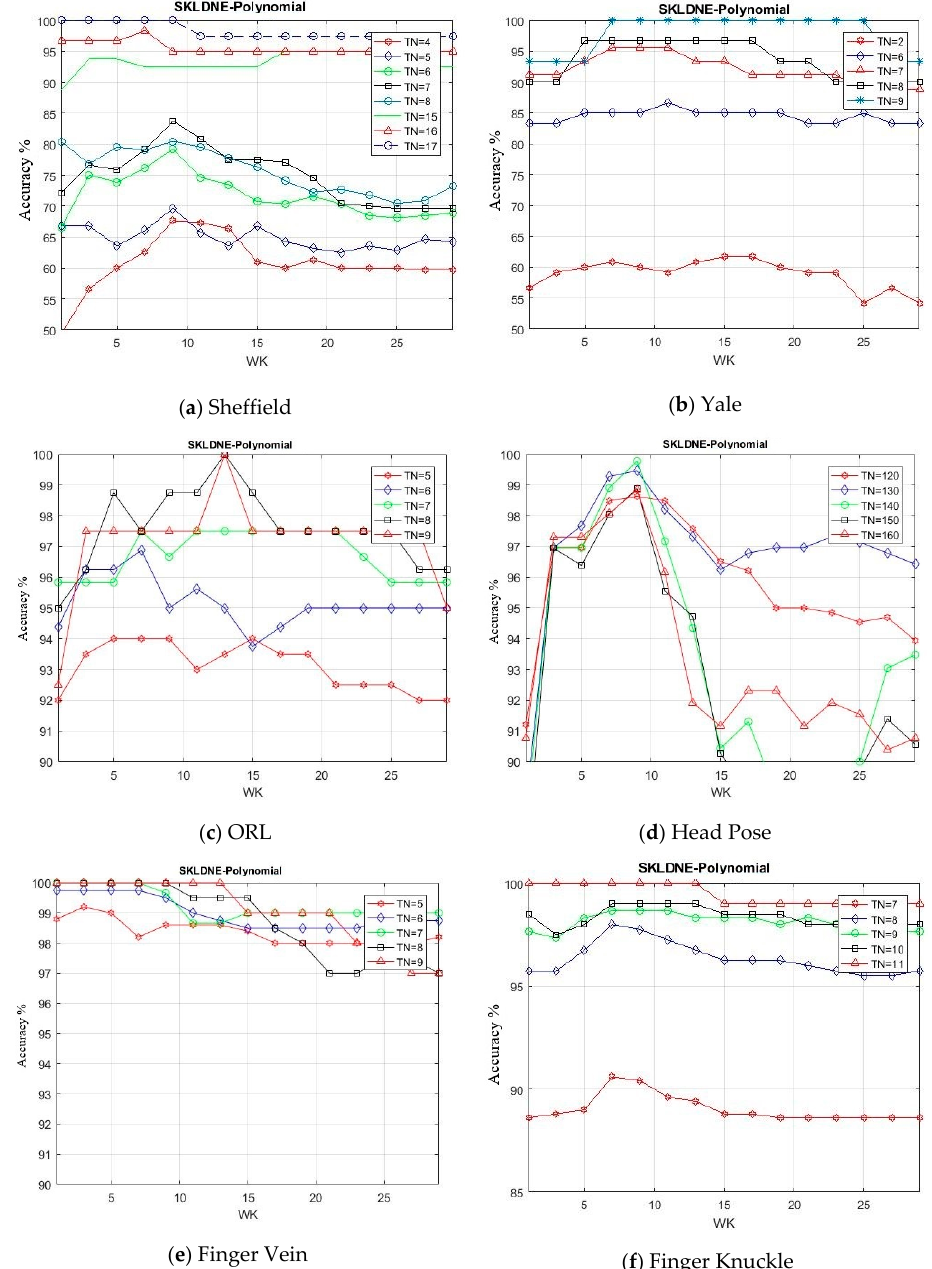
Figure 14. ( a – f ). Maximum recognition rate of SKLDNE versus Wk for different number of training samples on Sheffield, Yale, ORL, Head Pose, Finger Vein and Finger Knuckle databases.